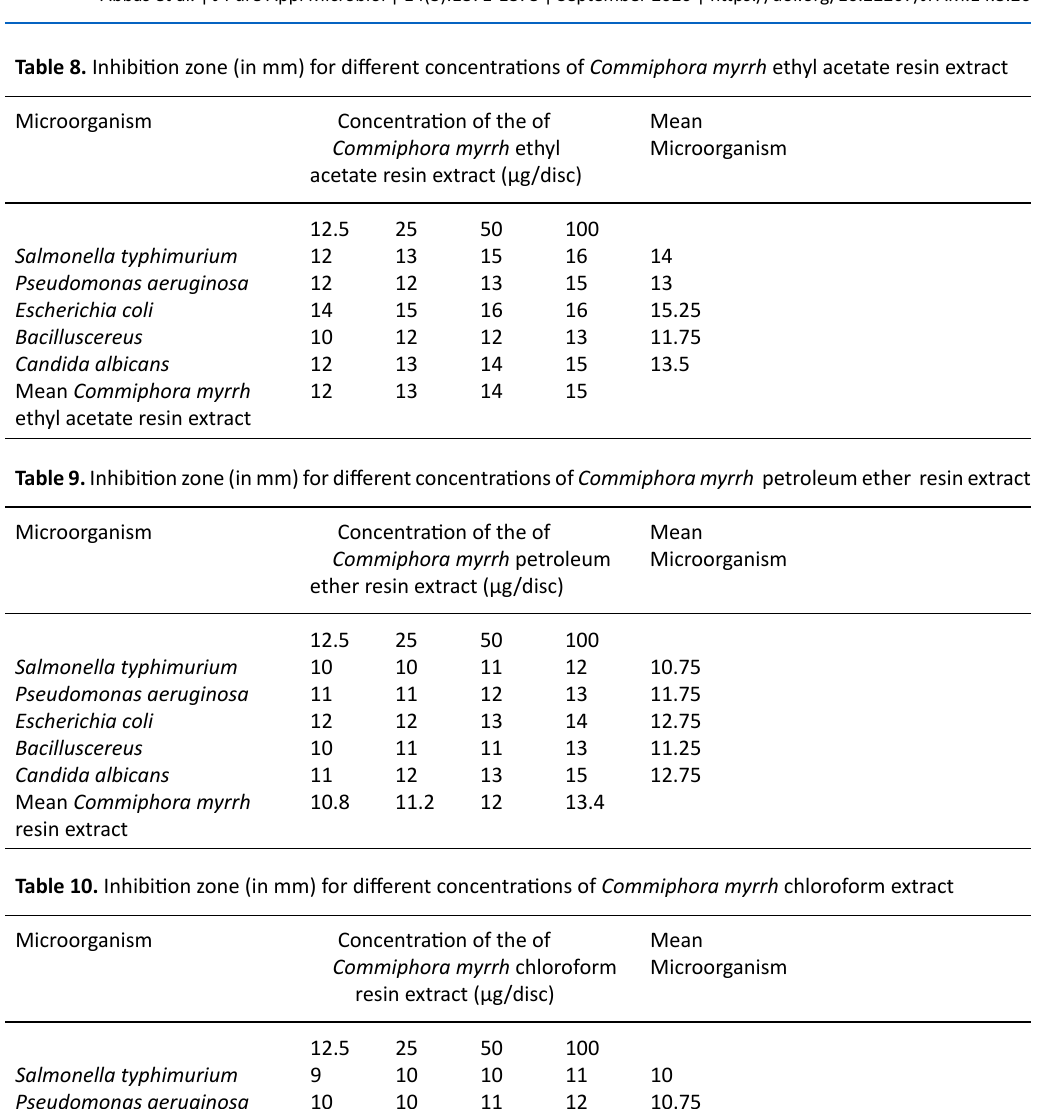
Table 8. Inhibition zone (in mm) for different concentrations of Commiphora myrrh ethyl acetate resin extract Microorganism Concentration of the of Mean Commiphora myrrh ethyl